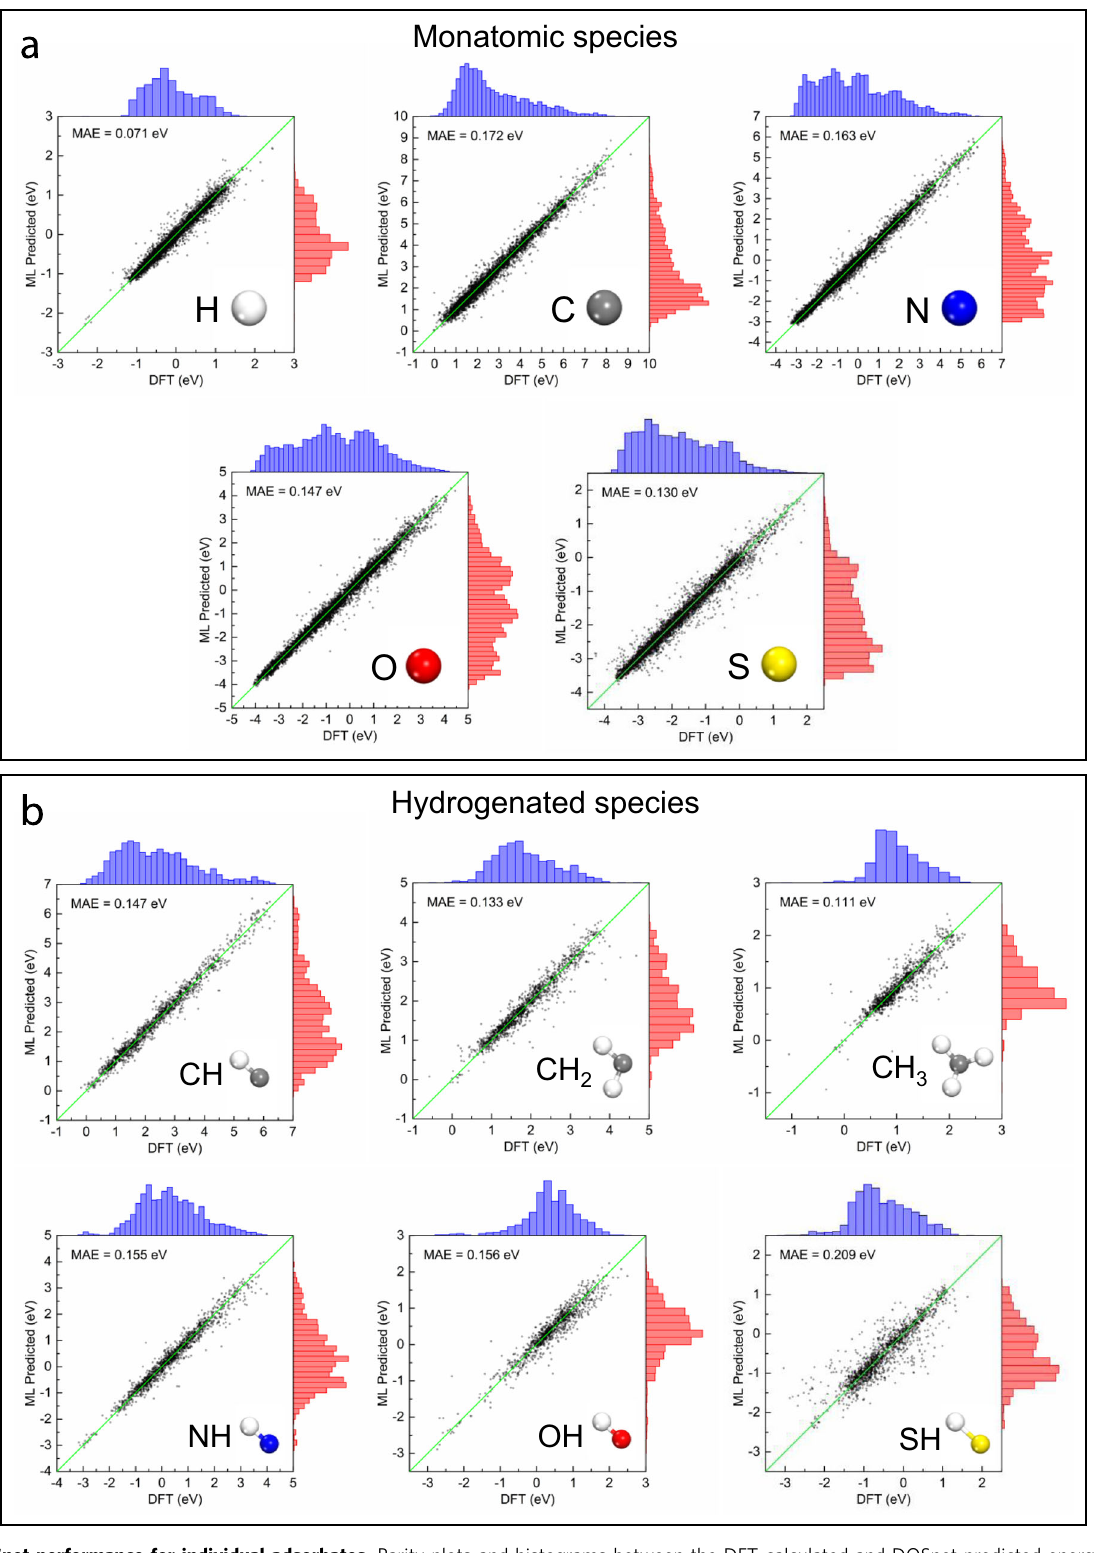
Fig. 2 DOSnet performance for individual adsorbates. Parity plots and histograms between the DFT-calculated and DOSnet predicted energies from fi vefold cross-validation are shown. Individual performances of DOSnet for each adsorbate are shown for a monatomic and b hydrogenated